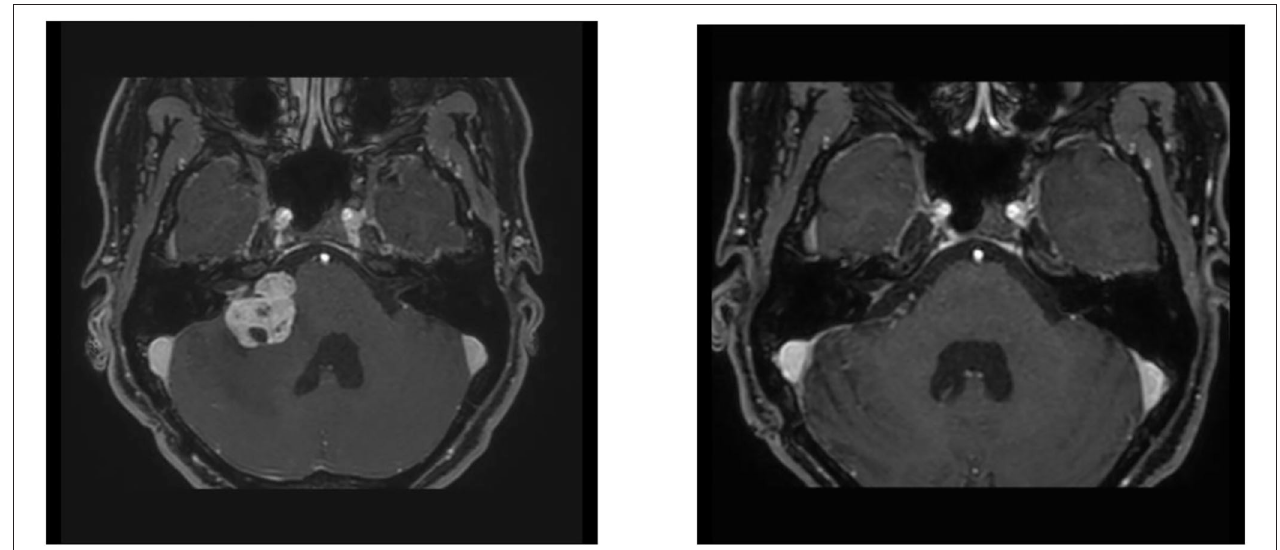
FIGURE 1 | A 43-year-old female patient with a cystic vestibular schwannoma on the right. On the left the preoperative findings, on the right the findings 3 months after the resection. Microsurgical resection under intraoperative monitoring. At the beginning of the resection, the amplitude of the EMG was 1.3mV and decreased to 0.48mV toward the end of the operation.